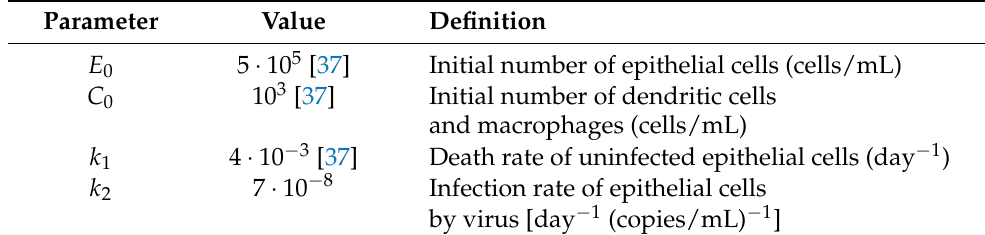
Table A1. Parameters for innate immune